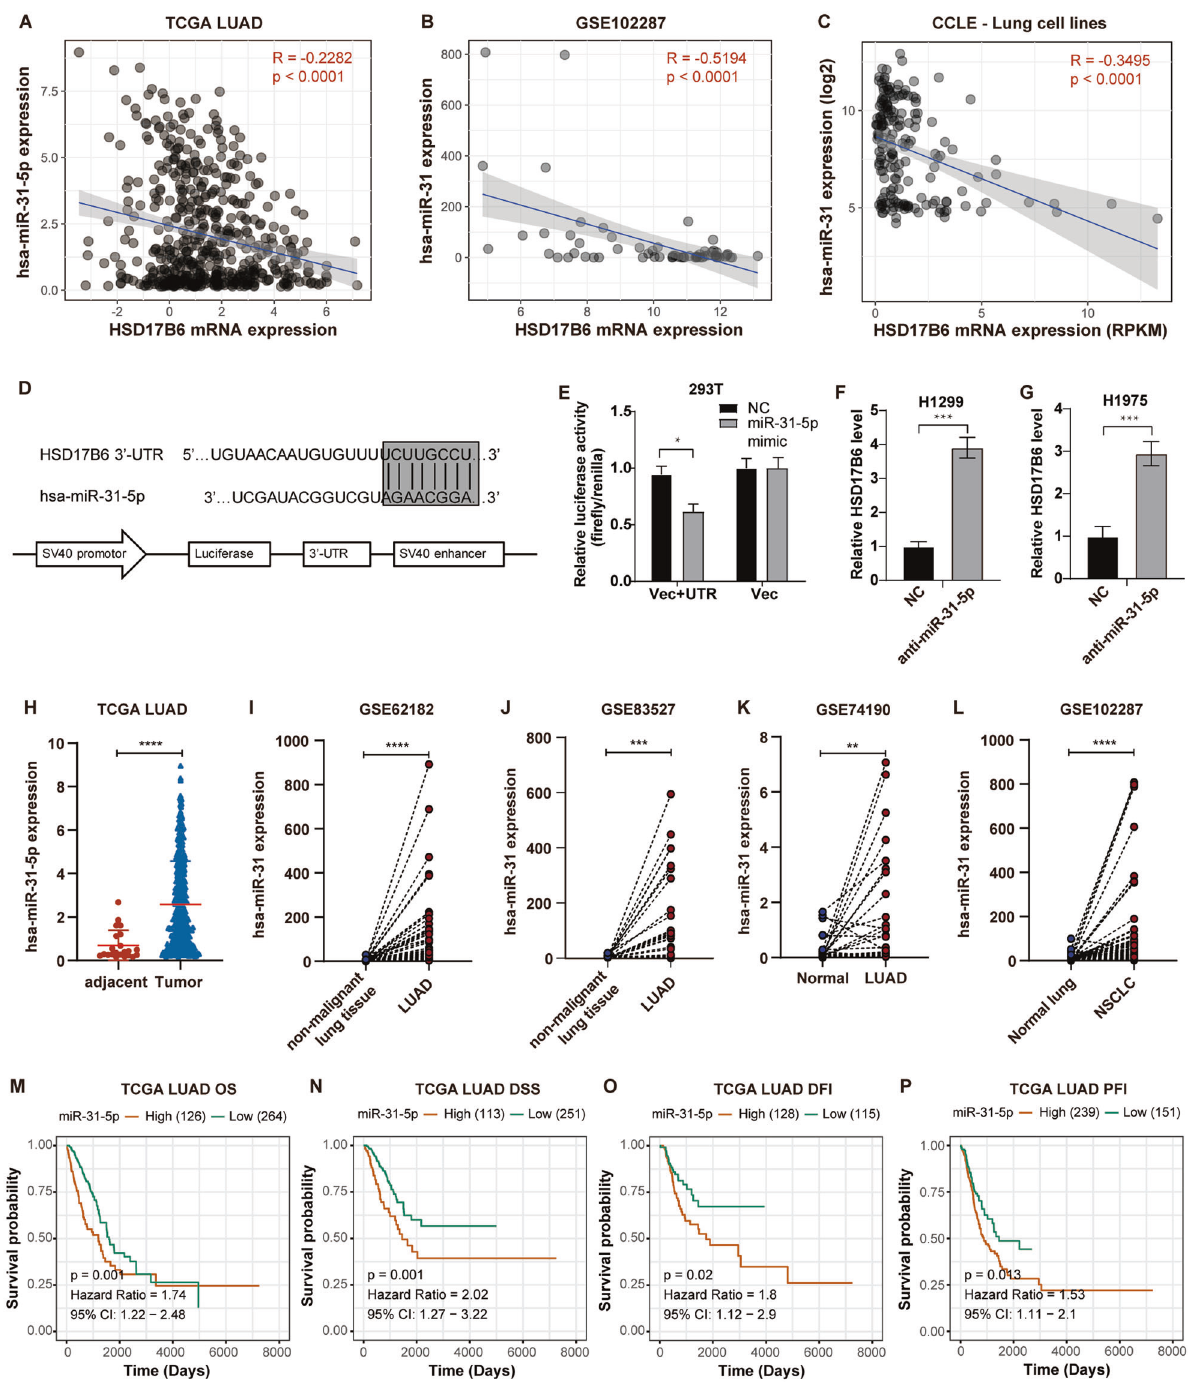
Fig. 4 HSD17B6 expression is regulated by miR-31-5p. A Correlation analysis between HSD17B6 mRNA expression and miR-31-5p expression in TCGA LUAD. B , C The correlation between HSD17B6 mRNA expression and miR-31 expression in GSE102287 dataset and CCLE lung cell lines. D A reporter plasmid with the 3 ′ -UTR of HSD17B6 gene targeted by miR-31-5p was constructed by inserting the UTR region downstream of the luciferase gene. E The relative luciferase activity (fold) of the vector with the HSD17B6-UTR sequence relative to the control vector (Vec, without UTR sequence) was determined in 293T cells transfected with the miR-31-5p mimic or scramble negative control (NC). The tests were repeated three times. Data were expressed as mean ± SD. F , G The effect of miR-31-5p inhibitor on the mRNA expression of HSD17B6 in H1299 and H1975 cells. The tests were repeated three times. Data were expressed as mean ± SD. H Comparison of miR-31-5p expression levels between adjacent normal tissues and LUAD tissues in TCGA LUAD. I – L Comparison of miR-31 expression levels between LUAD and paired non-cancerous samples in GSE62182, GSE83527, GSE74190, and GSE102287 datasets. M – P Kaplan – Meier analysis of OS, DSS, DFI, and PFI according to miR31-5p expression in the TCGA LUAD (red, high miR31-5p expression; green, low miR31-5p expression). OS overall survival, DSS disease-speci fi c survival, DFI disease-free interval, PFI progression-free interval, RFS recurrence-free survival. **** p < 0.0001, *** p < 0.001, ** p < 0.01, * p < 0.05.